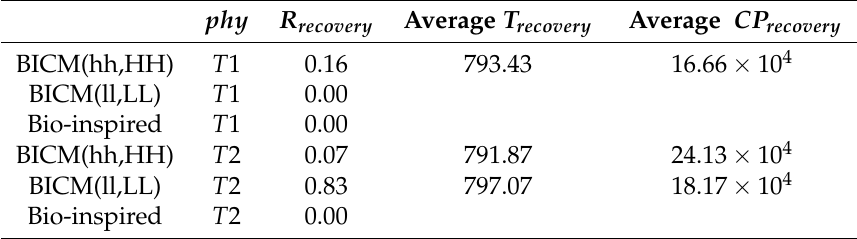
Table 6. The rate of recovering the data delivery ratio ( R recovery ) , the average time needed for data delivery ratio to recover to over 99.9% ( T recovery ) and the average number of control packets ( CP recovery ) when nodes are removed by targeted attack.